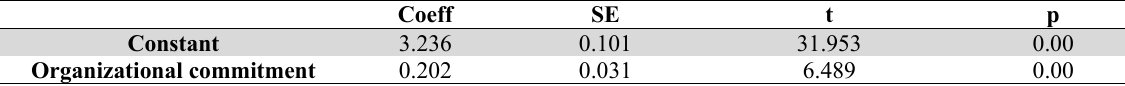
Total effect of organizational commitment on employees’ job performance